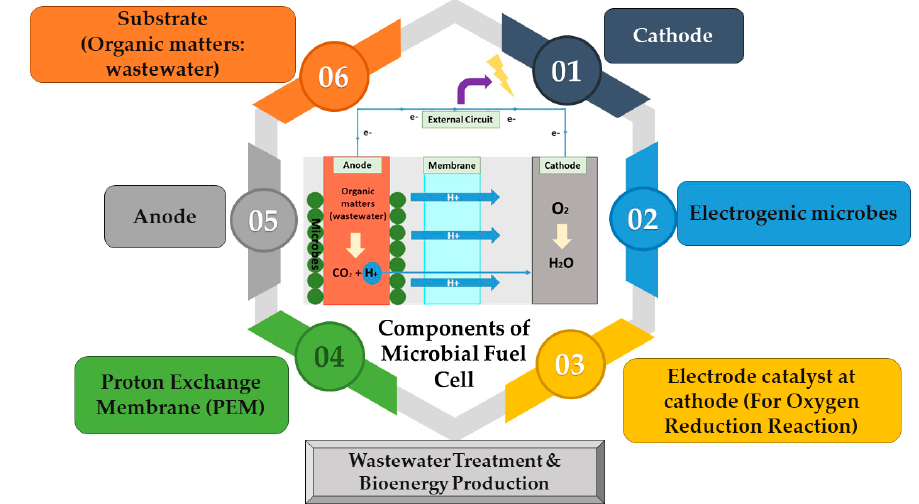
Figure 1. The component of microbial fuel cells (MFC).